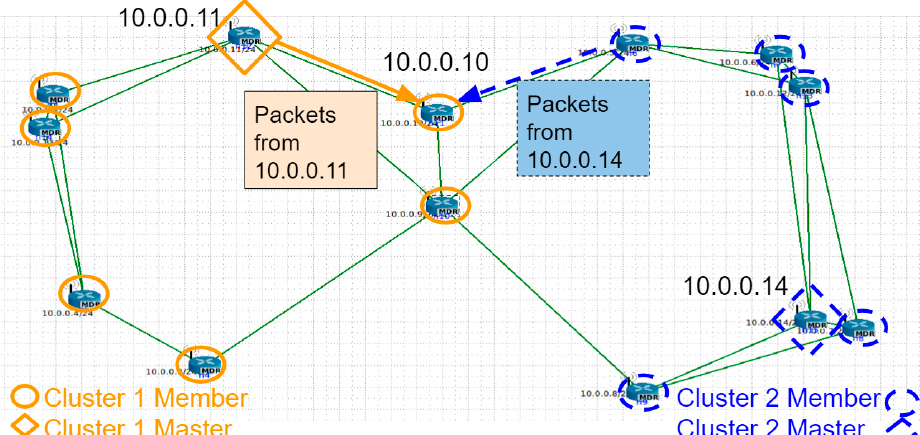
Figure 14. SIP distribution without edge conflict.